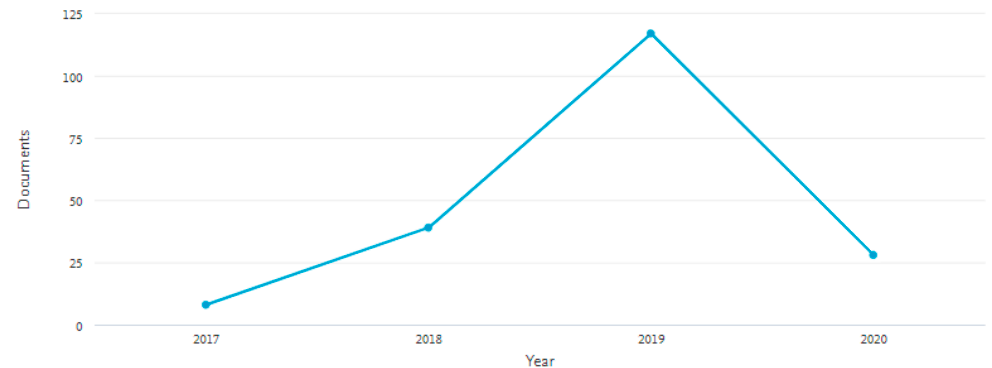
Figure 2. Distribution of articles over time by year of publication.